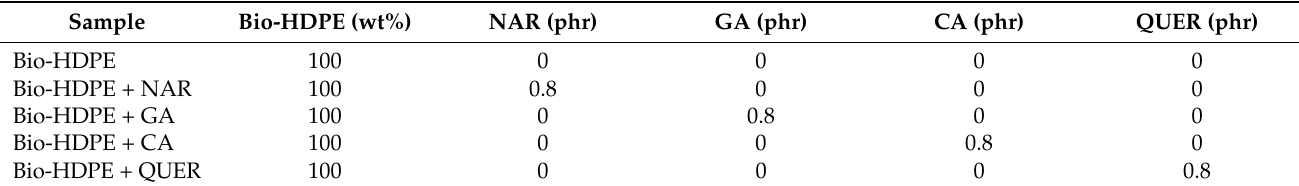
Table 1. Summary of compositions according to the weight (wt%) of bio-based high-density polyethylene (bio-HDPE) in which naringin (NAR), gallic acid (GA), caffeic acid (CA), and quercetin (QUER) were added as parts per hundred resin (phr) of